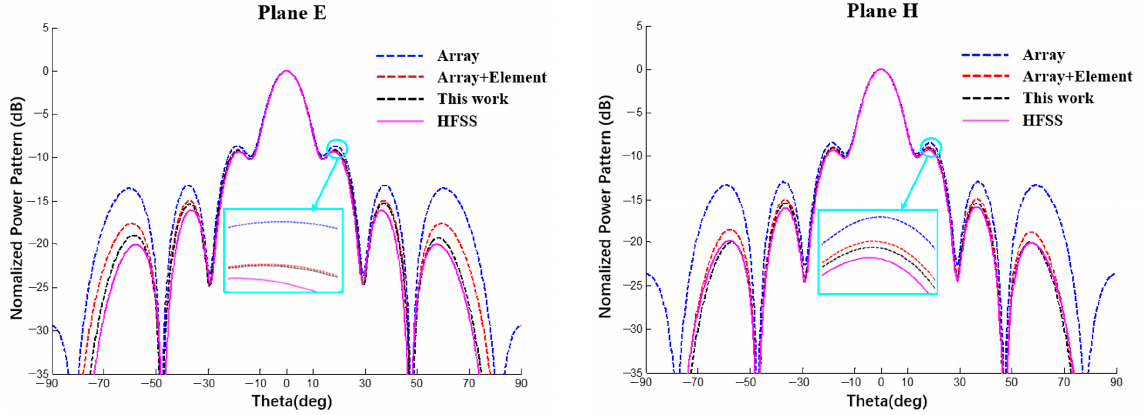
Figure 12. Comparison of simulation results between HFSS and MATLAB (Plane E, uniform excitation).